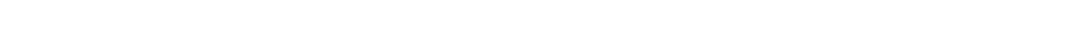
Frontiers in Oncology | Cancer MolecularTargets